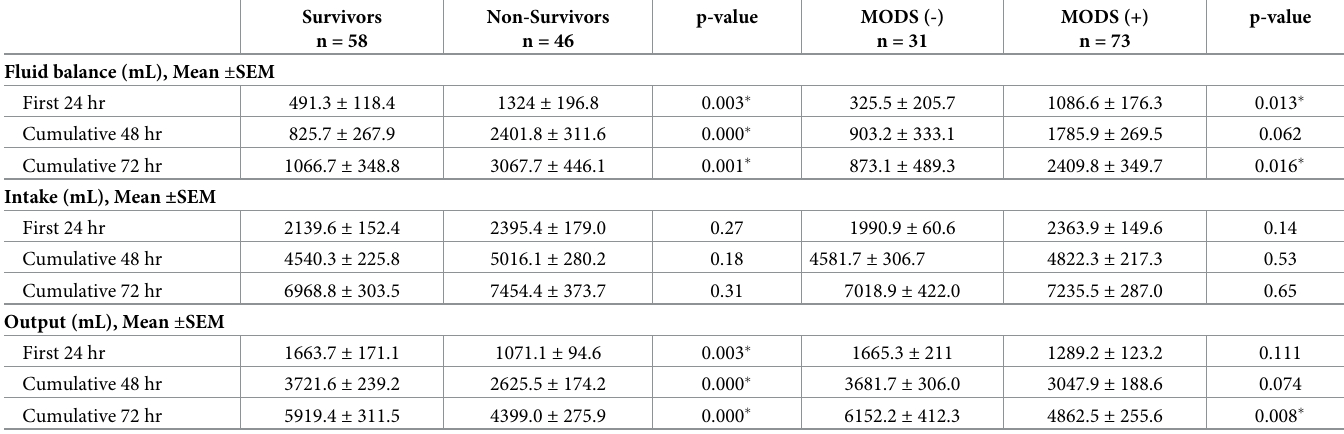
Table 4. Comparison of cumulative fluid balance (i.e., input and output in first 72 hours following onset of septic shock).